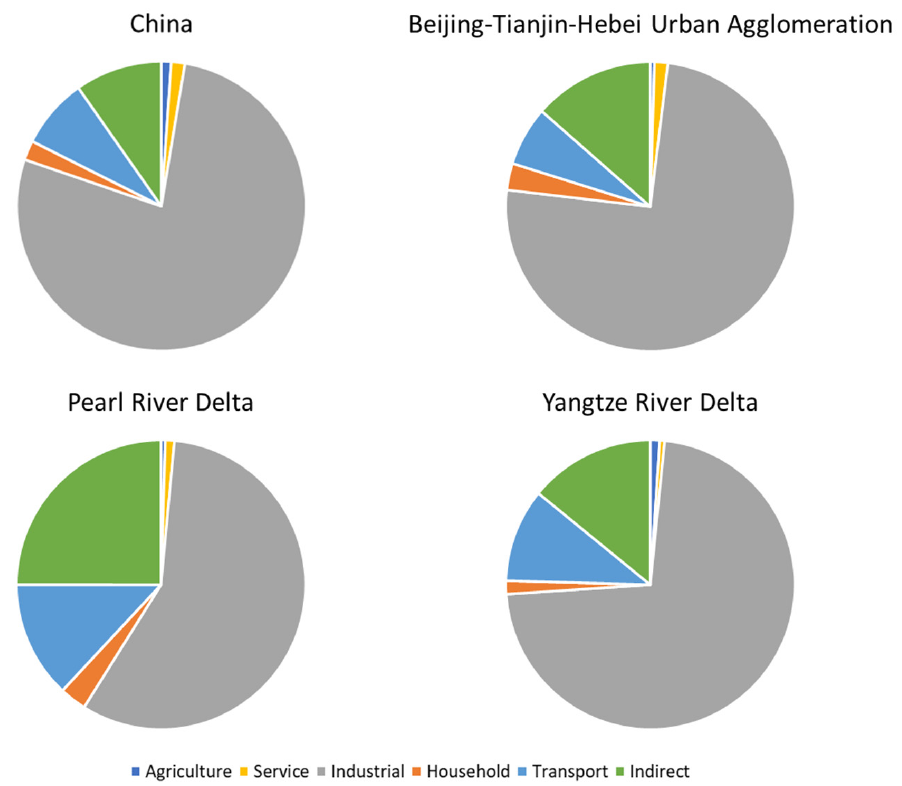
Figure 1. The proportion of CO 2 emissions in China and the three largest urban agglomerations. Direct emissions consist of emissions from agriculture, services, industry, households, and transportation.